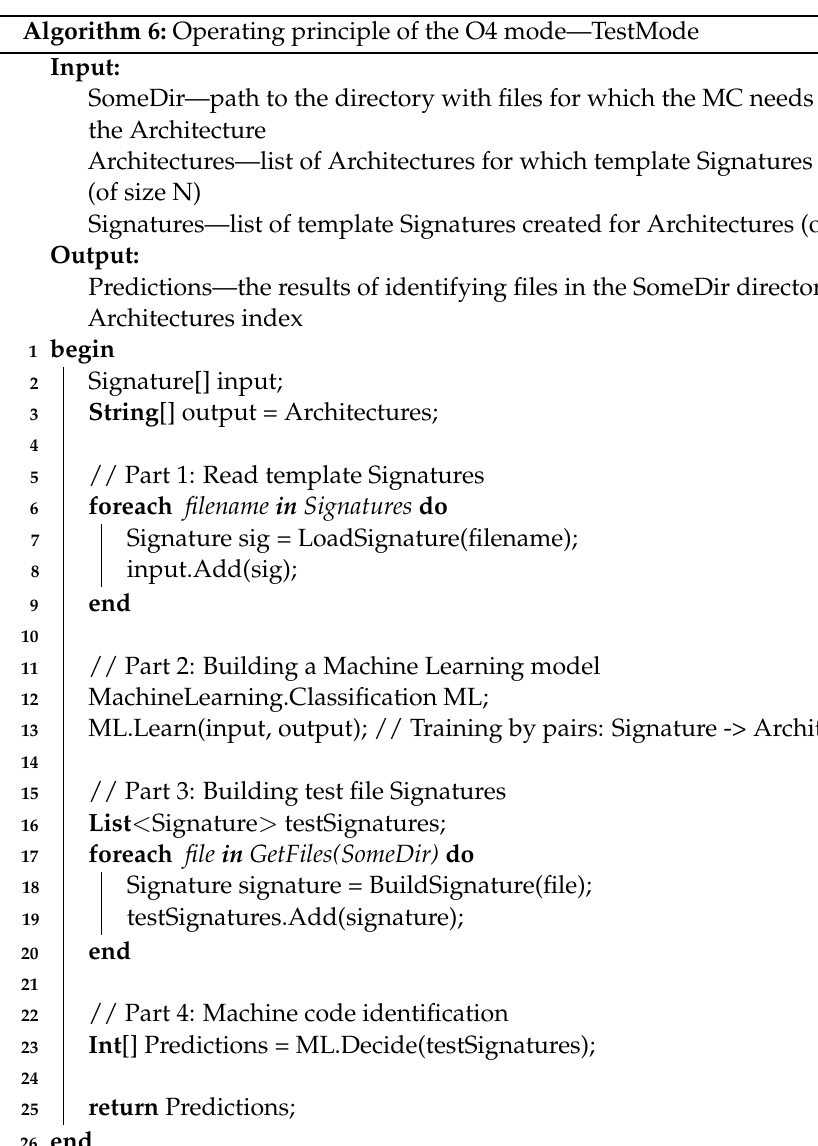
Algorithm 6: Operating principle of the O4